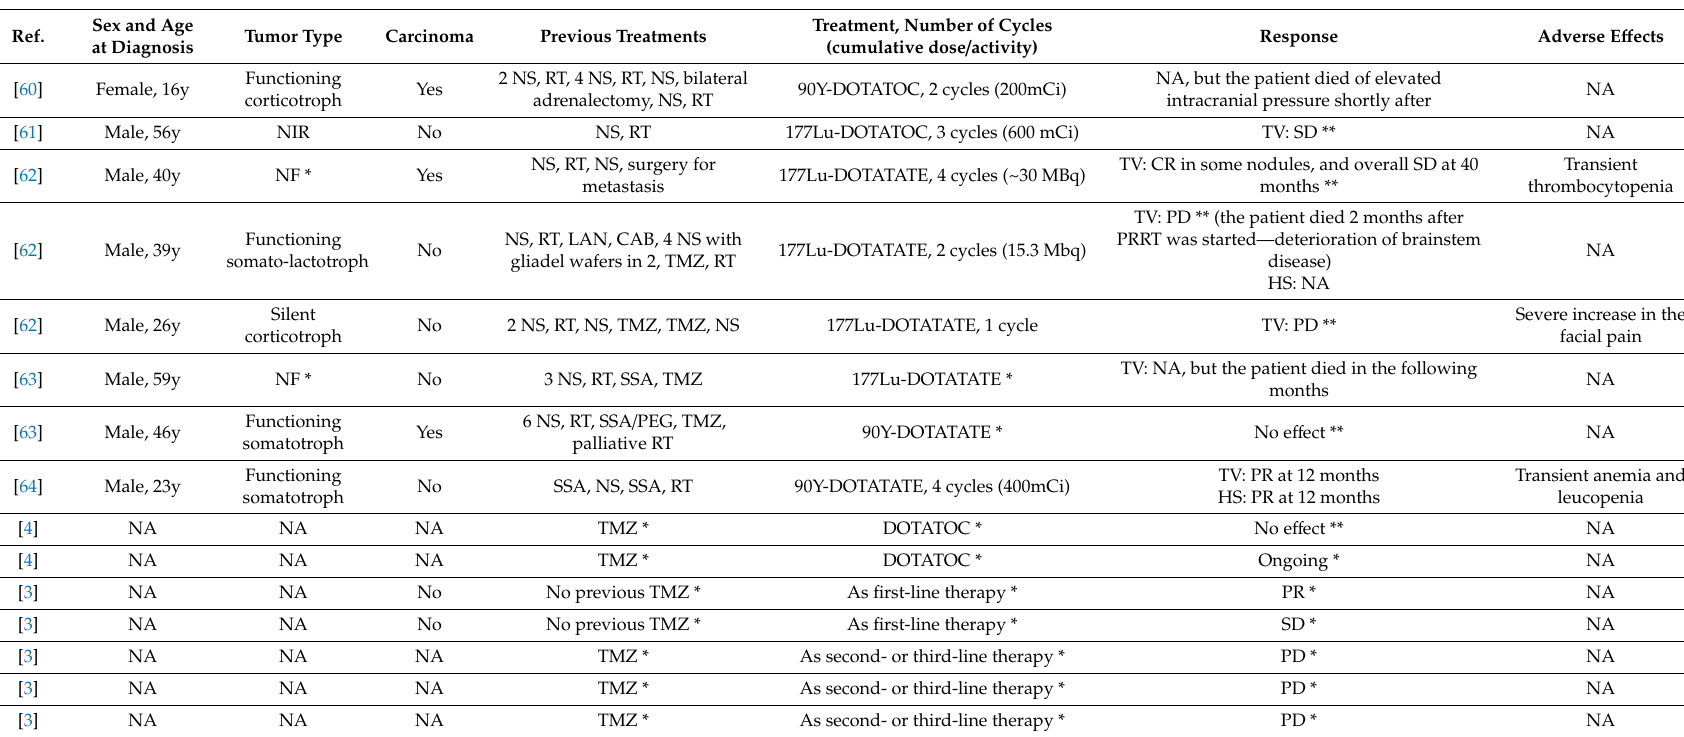
Table 4. Cases of aggressive pituitary neuroendocrine tumors and pituitary carcinomas treated with peptide receptor radionuclide therapy (PRRT).